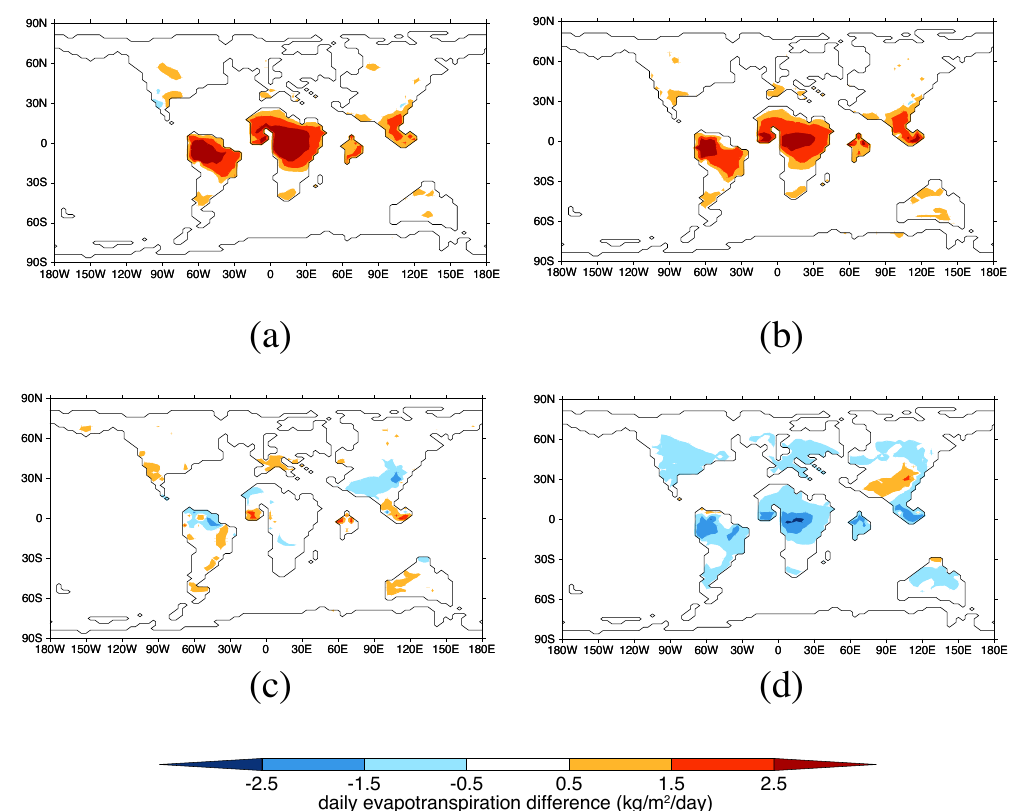
Fig. 12. Surface air temperature differences when vegetation distribution is changed from that of 2 × DYN to 4 × DYN but with CO 2 constant at 4 × (i.e. 4 × DYN − 4 × FIXED) (a) in JJA and (b) in DJF. Only differences at the 95% confidence level are